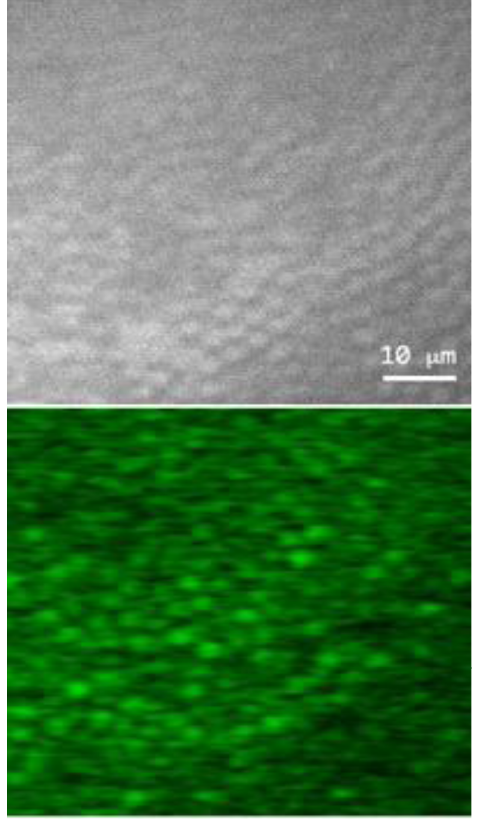
Figure 2. On the top transmission image, the bottom SRG image of polystyrene beads sample with a diameter of 3 μm. time is 16 s. The Lock-in amplifier (LIA) time constant was set to 100 s with an 18 dB/oct slope and a sensitivity of 10 V. For SRG images, the pump signal generated by Ti:Sa was set at 808 nm, while the probe signal generated by OPO was set at 1072 nm. For both of them, the average focused power was about 10 mW. For